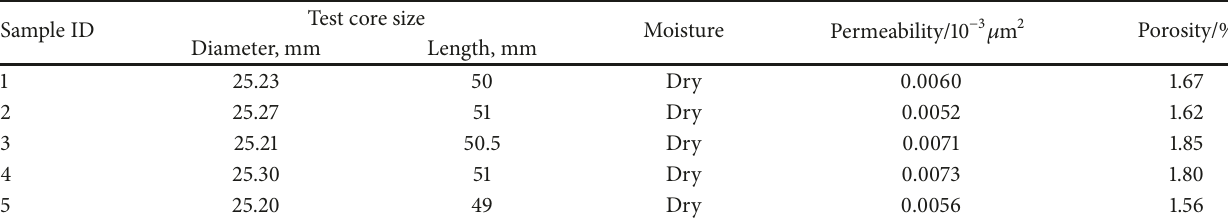
Table 1: Basic data of shale